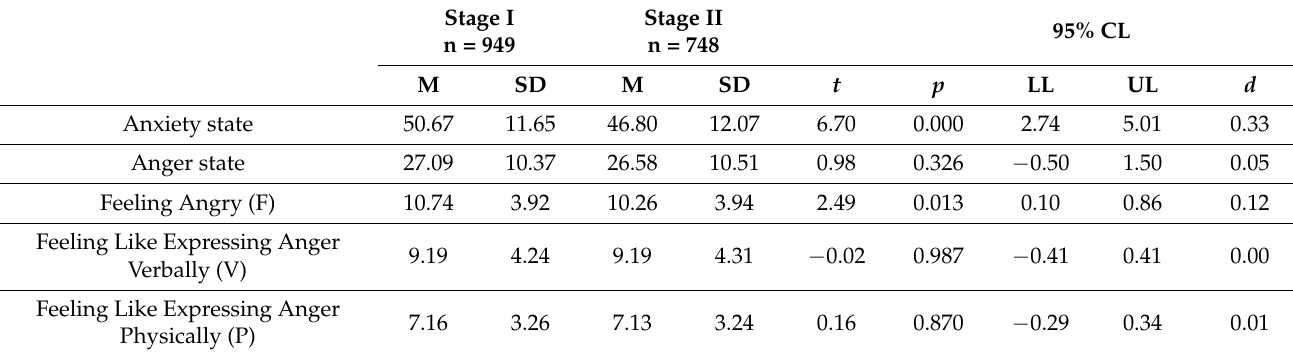
Table 4. The level of anxiety and anger during stages I and